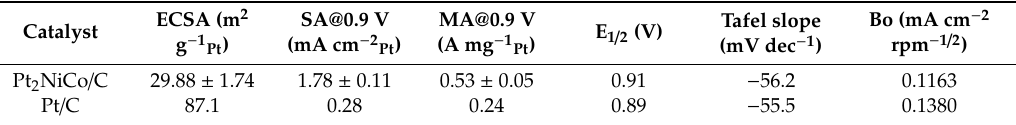
Table 1. Kinetic parameters toward the oxygen reduction reaction (ORR) of the Pt 2 NiCo / C and commercial Pt / C nanocatalysts in O 2 -saturated 0.1 M HClO 4 .